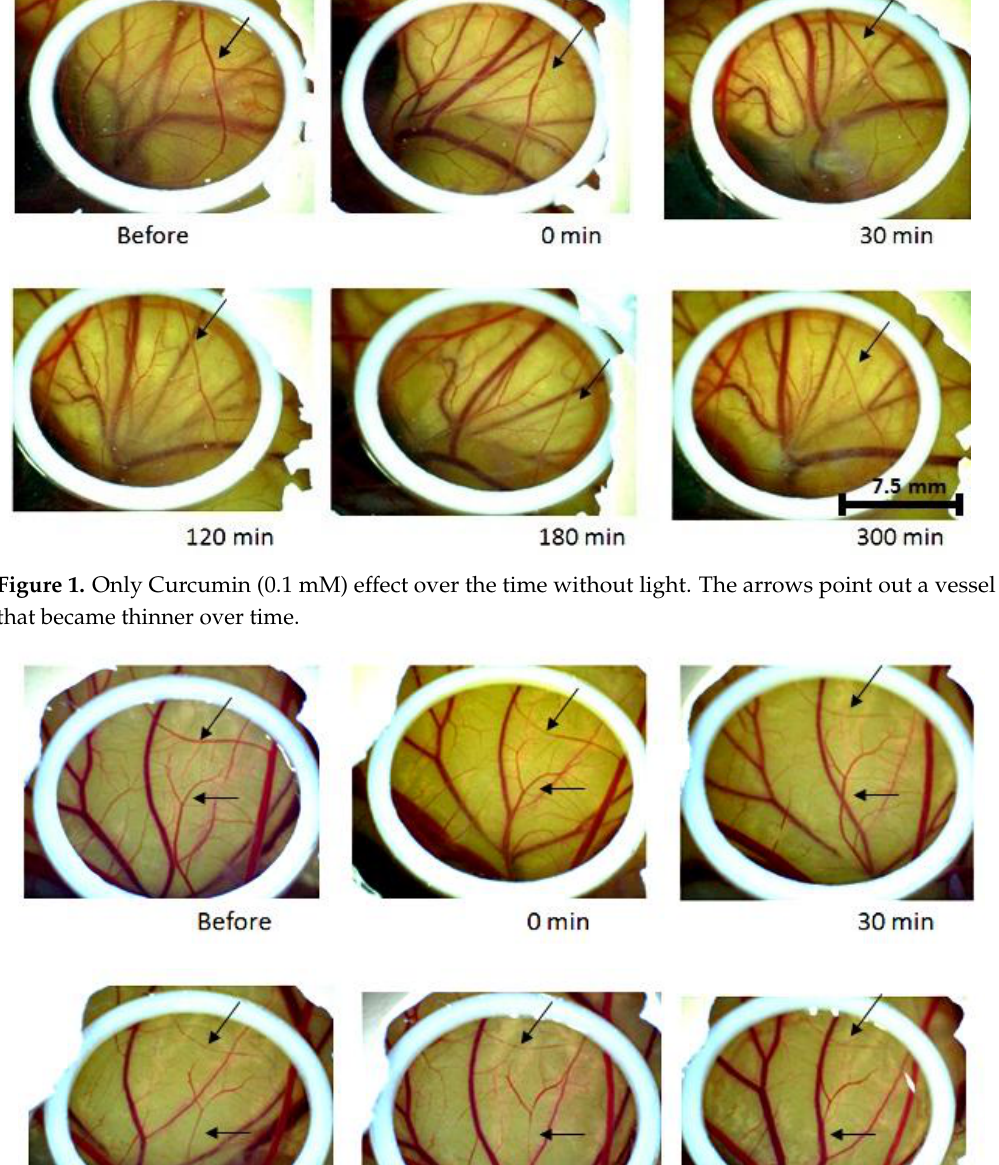
Figure 1. Only Curcumin (0.1 mM) effect over the time without light. The arrows point out a vessel that became thinner over time.